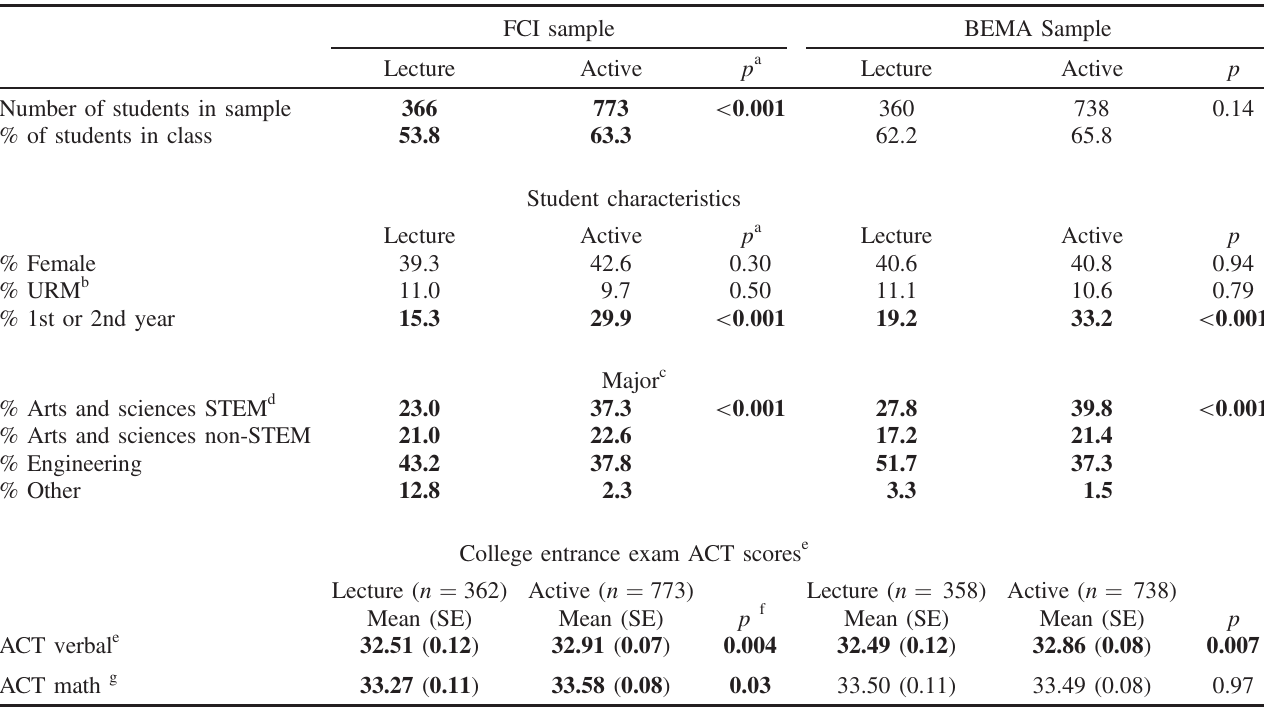
TABLE II. Demographics for students taking the FCI and BEMA. Bold cells indicate a significant difference between traditional- lecture physics and Active Physics. SE indicates Standard